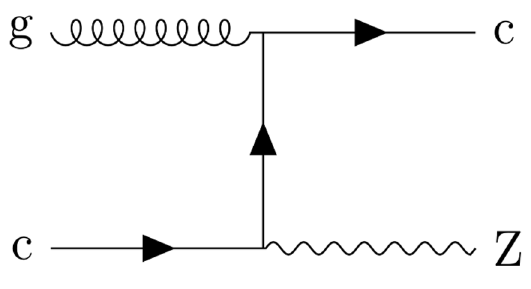
Figure 1 . Example Feynman diagram for the Z + c jet